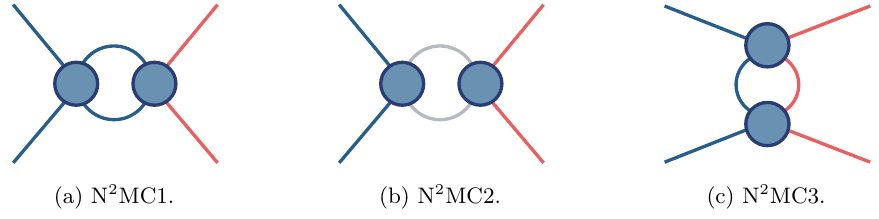
Figure 4 . All next-to-next-to-maximal cuts of the one-loop four-point amplitude, not including tadpole graphs. Dark blue blobs represent four-point amplitudes, and exposed legs represent on- shell